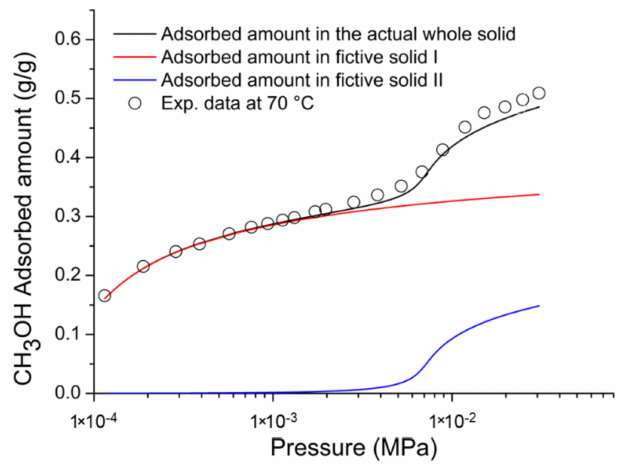
Figure 10. Comparison between experimental data [58] and simultaneous optimized model fitting (solid lines), showing the two additional contributions associated with the fictive solids I (RALFHB) and II